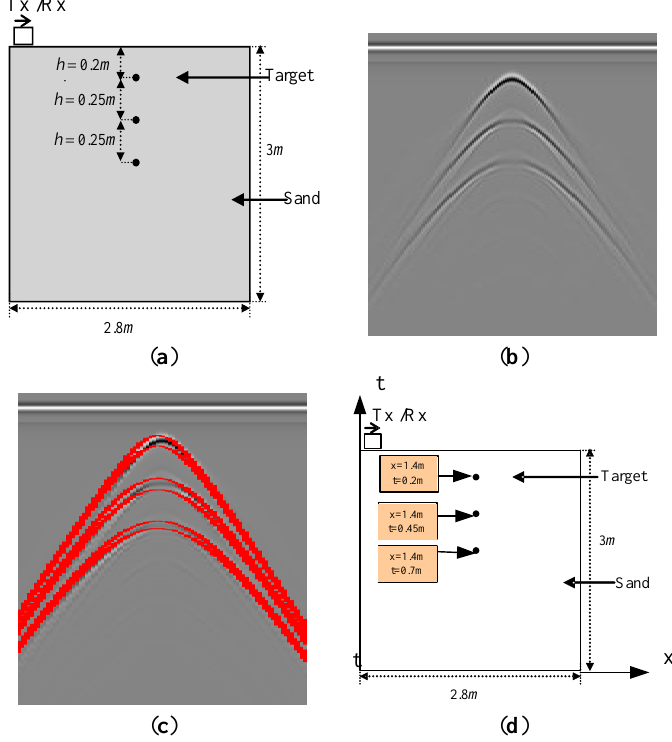
Figure 7. One more example of using MMSA. ( a ) Ground truth of the image; ( b ) GPR image; ( c ) The hyperbola result of the Hough transform; ( d ) The position estimation result of the detection method.